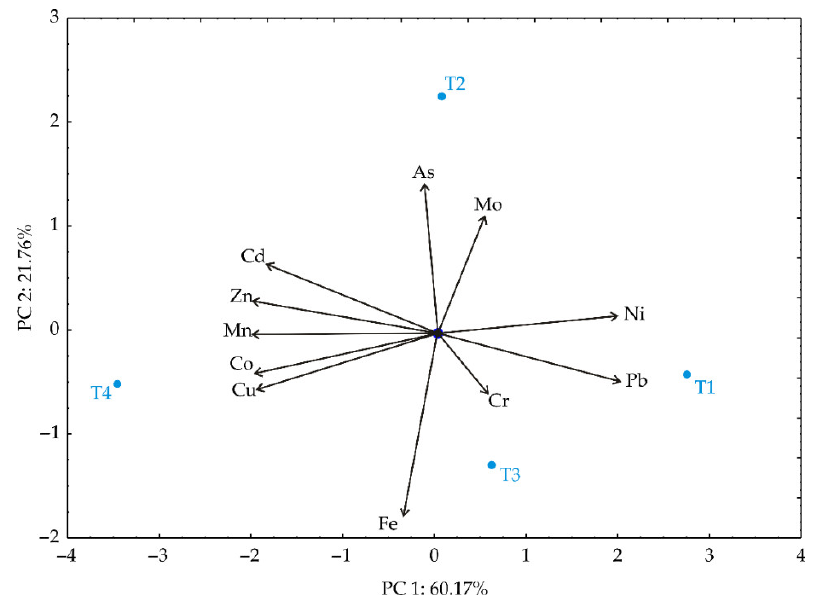
Figure 2. Biplot graph of soil samples based on heavy metals concentration. T1—(control), T2—1.66 t/ha, T3—3.32 t/ha, T4—6.64 t/ha.